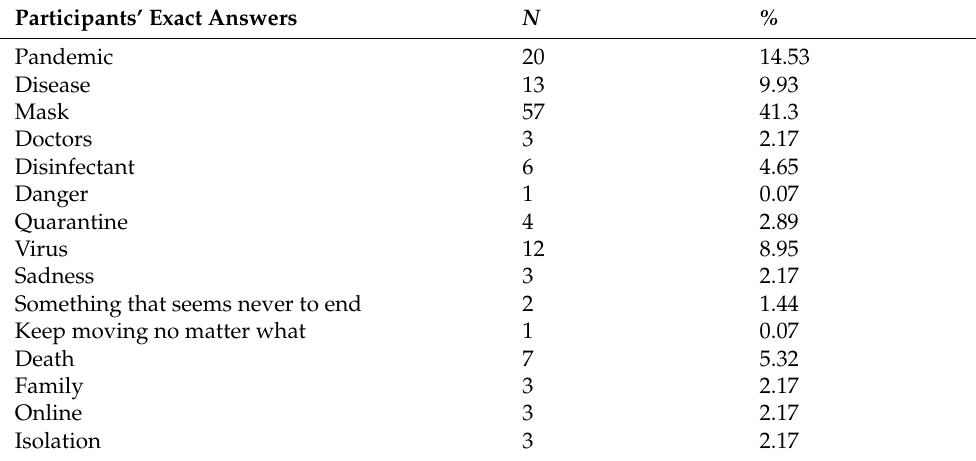
Table 1. Participants’ answer to Question 1: “When you think about the COVID-19 pandemic, which are the first three words that come to your mind?”.